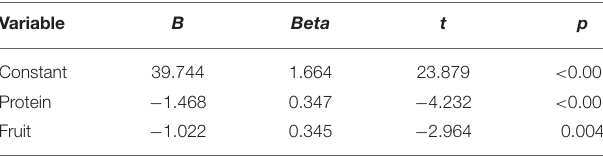
TABLE 5 | Regression analysis of diet consumption on experience of frequent and urgent